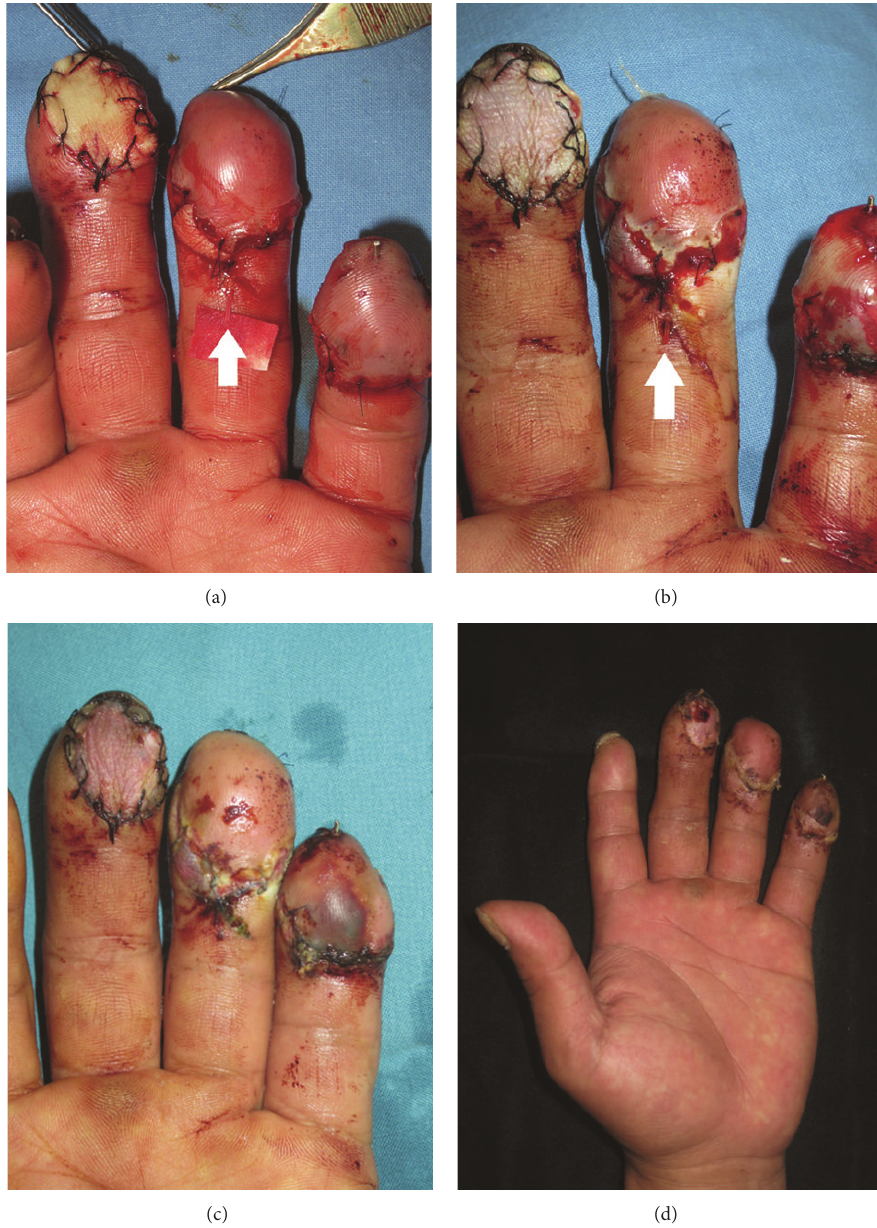
Figure 3: (a) Details of Case 2. (a) Immediate postoperative view. A full-thickness skin graft was done on the third finger, and the fifth finger was replanted via anastomosis of one artery and one vein. The mechanical leech procedure using an angioneedle (arrow) was performed on the fourth finger. (b) View on postoperative day 4. The angioneedle is located proximal to the amputated portion (arrow). (c) The patient was discharged on postoperative day 7. The angioneedle was removed on postoperative day 5, and all digits were reconstructed successfully. (d) 3 weeks after the operation. The patient was encouraged to exercise and had gone back to his normal daily